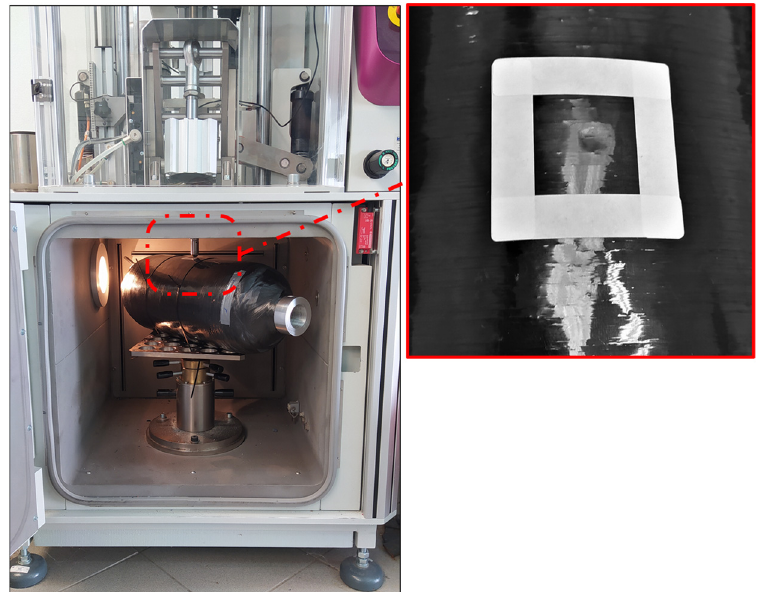
Figure 4. Impact setup on the CFRP tank.